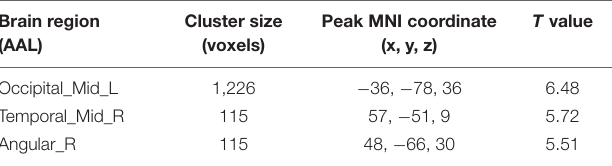
TABLE 2 | Regions with significant fALFF differences between mTBI patients and CN.